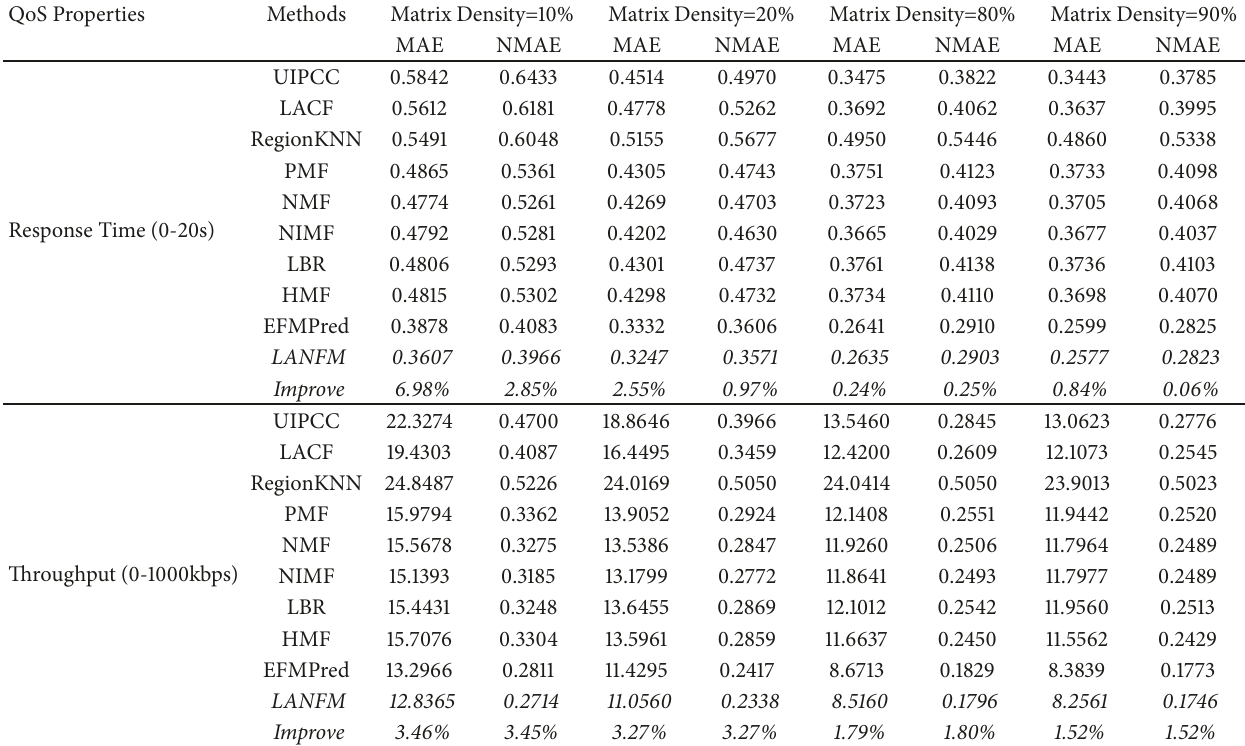
Table 7: Quality of services prediction accuracy